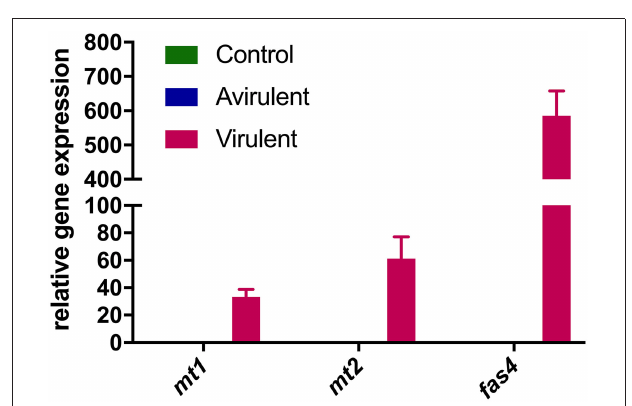
FIGURE 2 | Relative expression of mt1, mt2, and fas4 in R. fascians cultures. Expression was determined following culture of R. fascians avirulent strain 589 (Avirulent) and virulent strain 602 (Virulent), followed by RNA extraction and cDNA synthesis. A no-template reaction was used as control. Relative fold changes were determined using 16S rRNA as internal reference gene. The error bars are ± 1s.d. of the three biological replicates in the